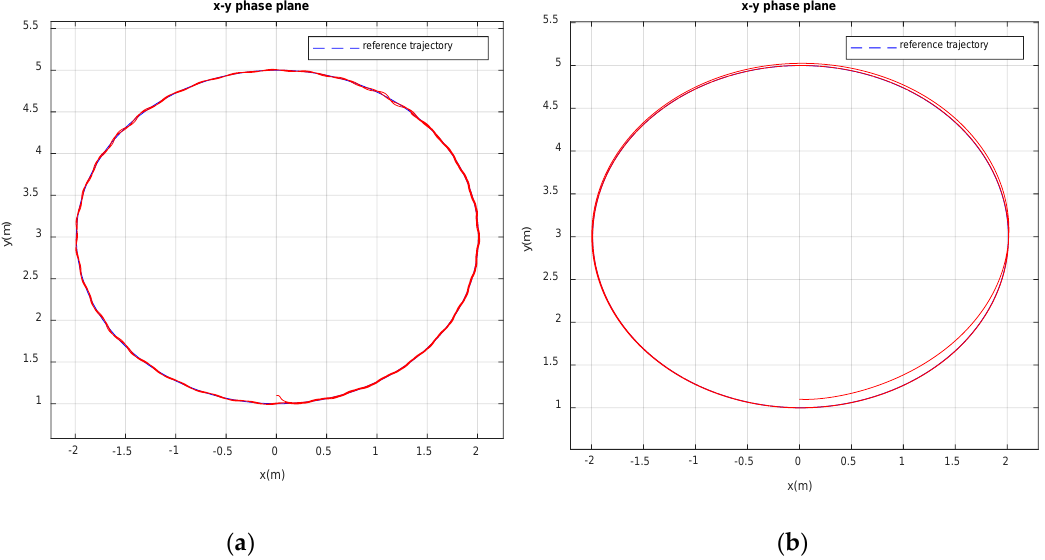
Figure 13. Tracking performance of circular trajectory by Typical robust nonlinear control (TRNC) ( a ) and proposed controller ( b